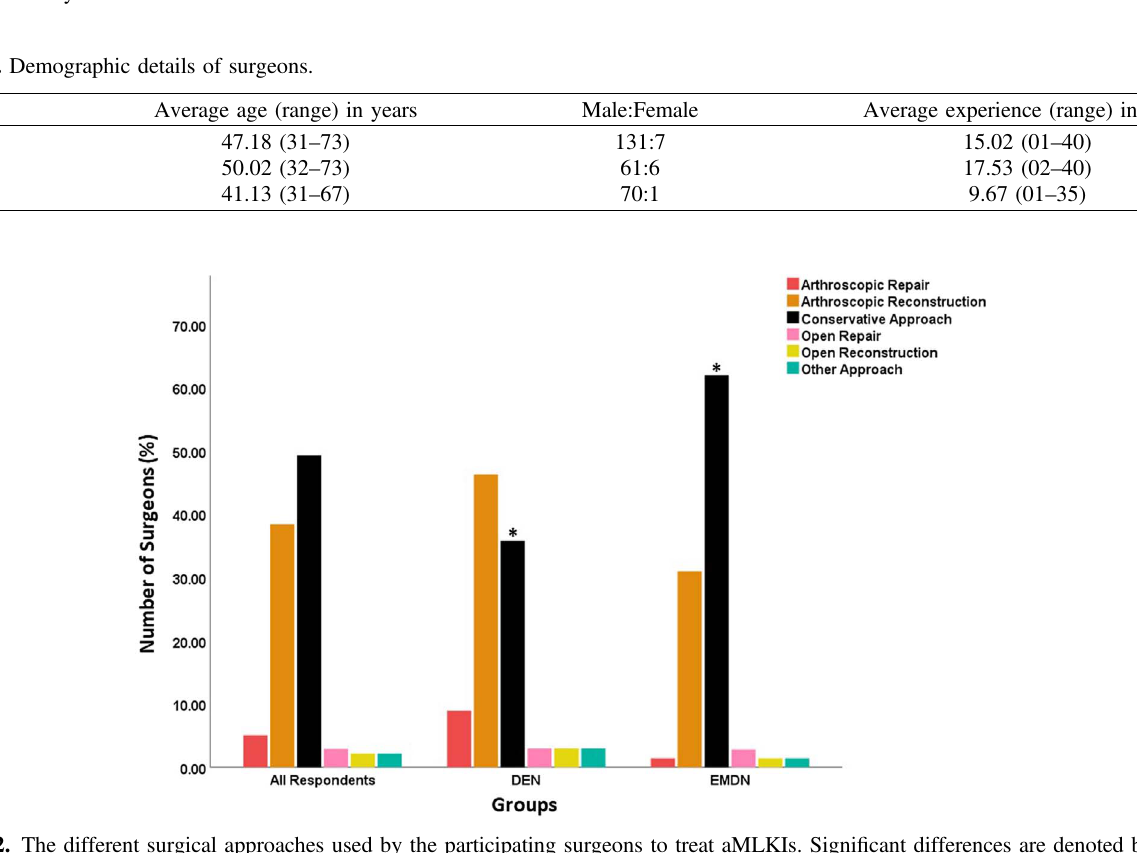
Figure 2. The different surgical approaches used by the participating surgeons to treat aMLKIs. Signi fi cant differences are denoted by *.